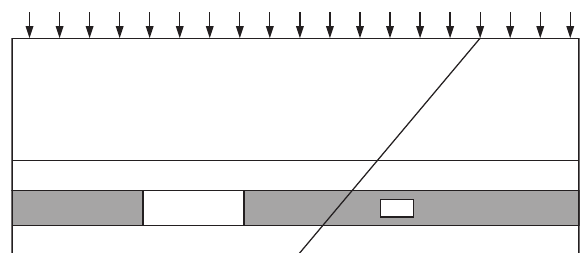
Figure 16: The numerical model of forward direction fault (the periodical fracture).